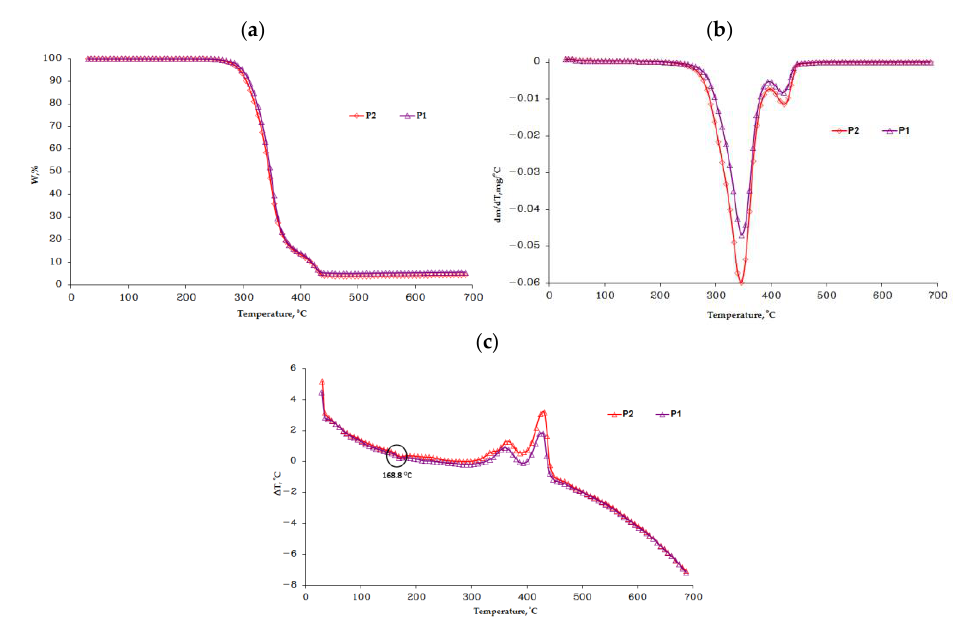
Figure 7. Thermogravimetric curves: ( a ) TG, ( b ) DTG and ( c ) DTA. From the thermogravimetric curves, the main thermal characteristics for the samples (granule and injected sample) were obtained, which are presented in Table 3. Table 3. Thermogravimetric characteristics.